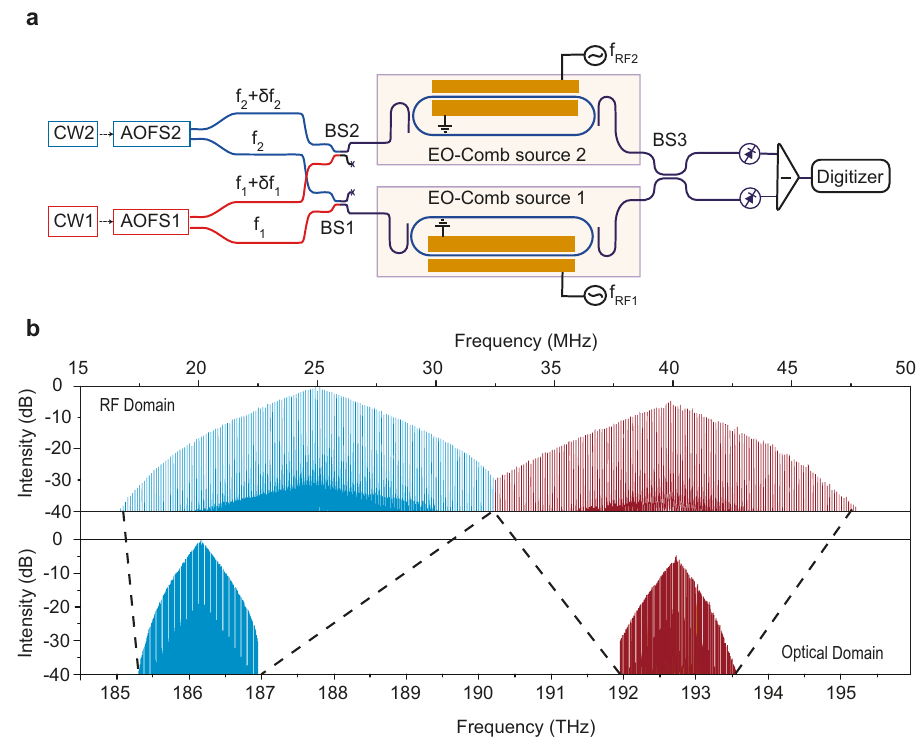
Fig. 4 Spectrally-tailored dual-comb spectrometer. a Experimental set up. CW, continuous-wave laser; RF, radio frequency; AOFS, acousto-optic frequency shifter; BS, beam splitter. CW1 and CW2 with f 1 = 192.7 THz and f 2 = 186.1 THz pass through two AOFS (with δ f 1 = 40 MHz, and δ f 2 = 25 MHz), respectively. CW1 and CW2 are injected into EO-Comb source1, while their frequency-shifted replica are sent to EO-Comb source2 with f = 10.45 GHz) and f -f = 0.1 MHz. The outputs are heterodyned on a balanced detector, and the time-domain interference signal is digitized with a RF1 RF2 RF1 data acquisition board. b Dual-comb spectrum with a measurement time of 9.8 s. The two RF combs, which center frequencies are 15 MHz apart, correspond to two EO combs that are 6.6 THz apart in the optical